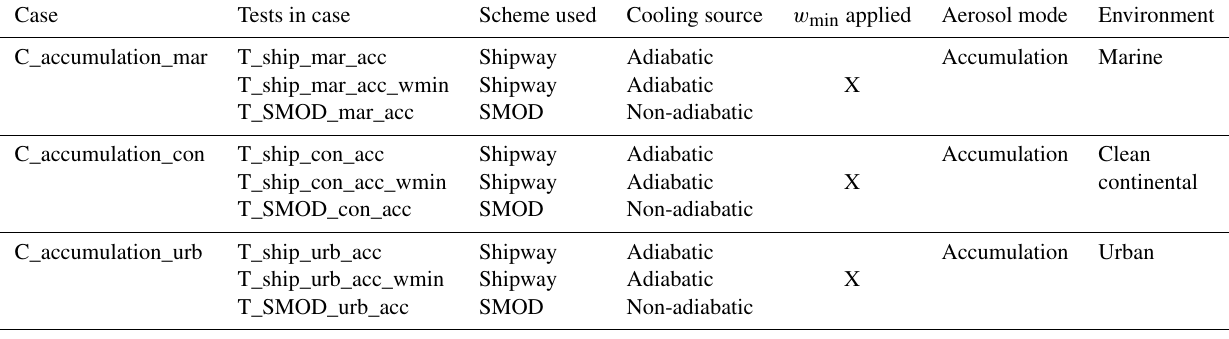
Table 3. The tests conducted in the offline box model used to test activation scheme representation and appropriate use of w min .